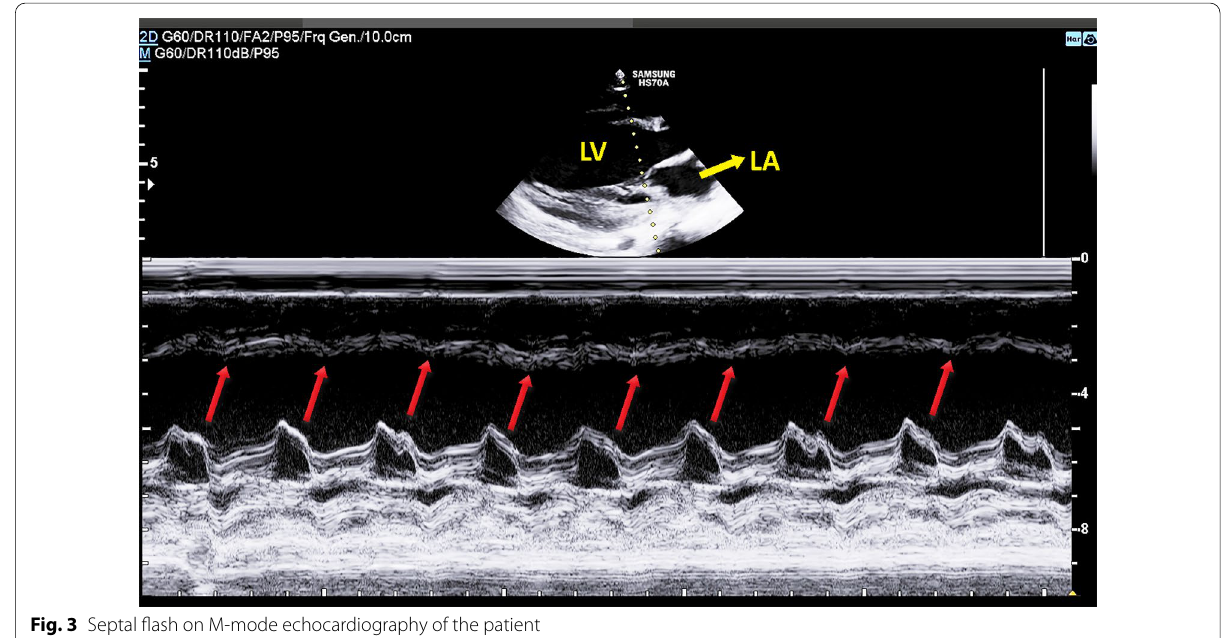
Fig. 3 Septal flash on M-mode echocardiography of the patient